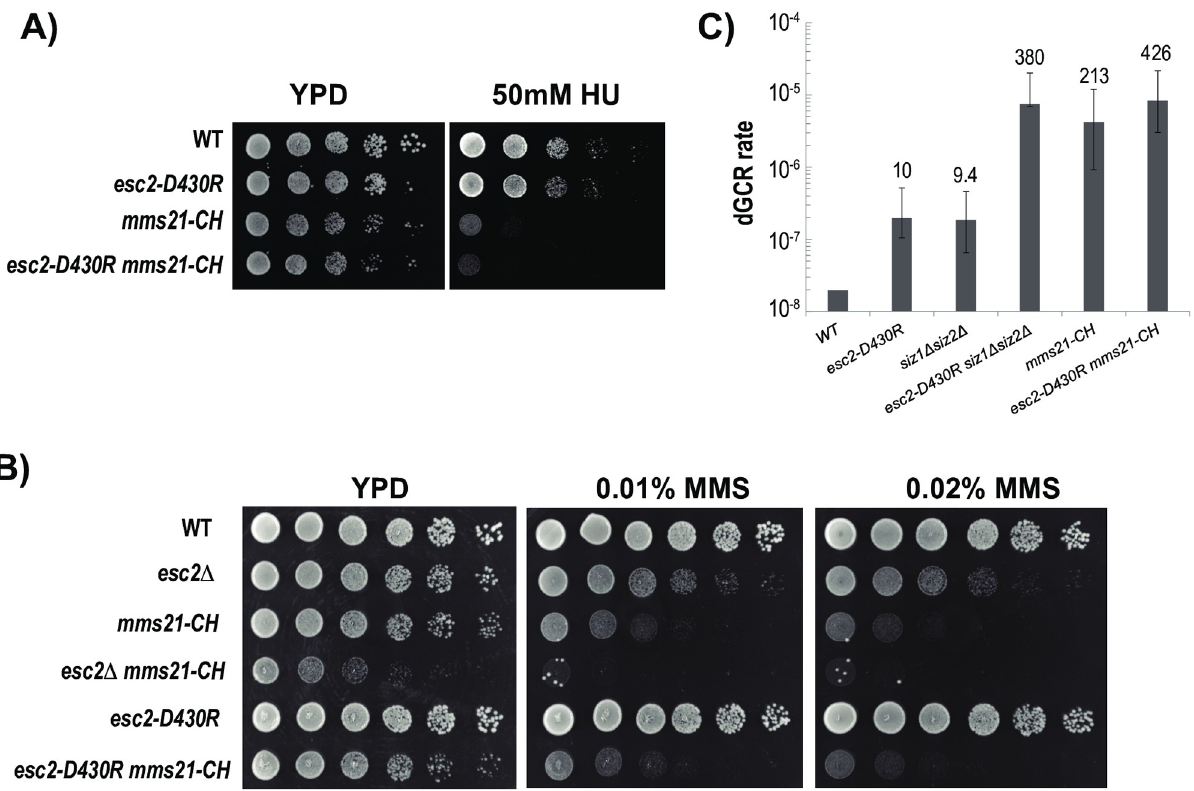
Fig 4. Effect of esc2-D430R on DNA damage sensitivity and the rate of accumulating dGCRs. A) Spot assay to evaluate the growth of the esc2-D430R , mms21-CH and esc2-D430R mms21-CH mutants in response to hydroxyurea (HU) treatment. B) Spot assay to evaluate the growth of esc2 and mms21-CH mutants in response to methyl methanesulfonate (MMS) treatment. C) dGCR rates of esc2-D430R alone and together with siz1 Δ siz2 Δ and mms21-CH mutants. Error bars represent the upper and lower bounds of the 95% confidence interval with fold changes relative to WT shown above each respective analysis.